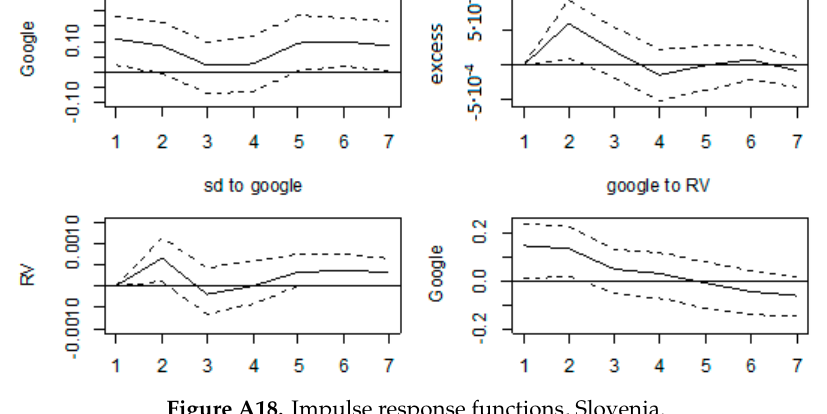
Figure A18. Impulse response functions, Slovenia.